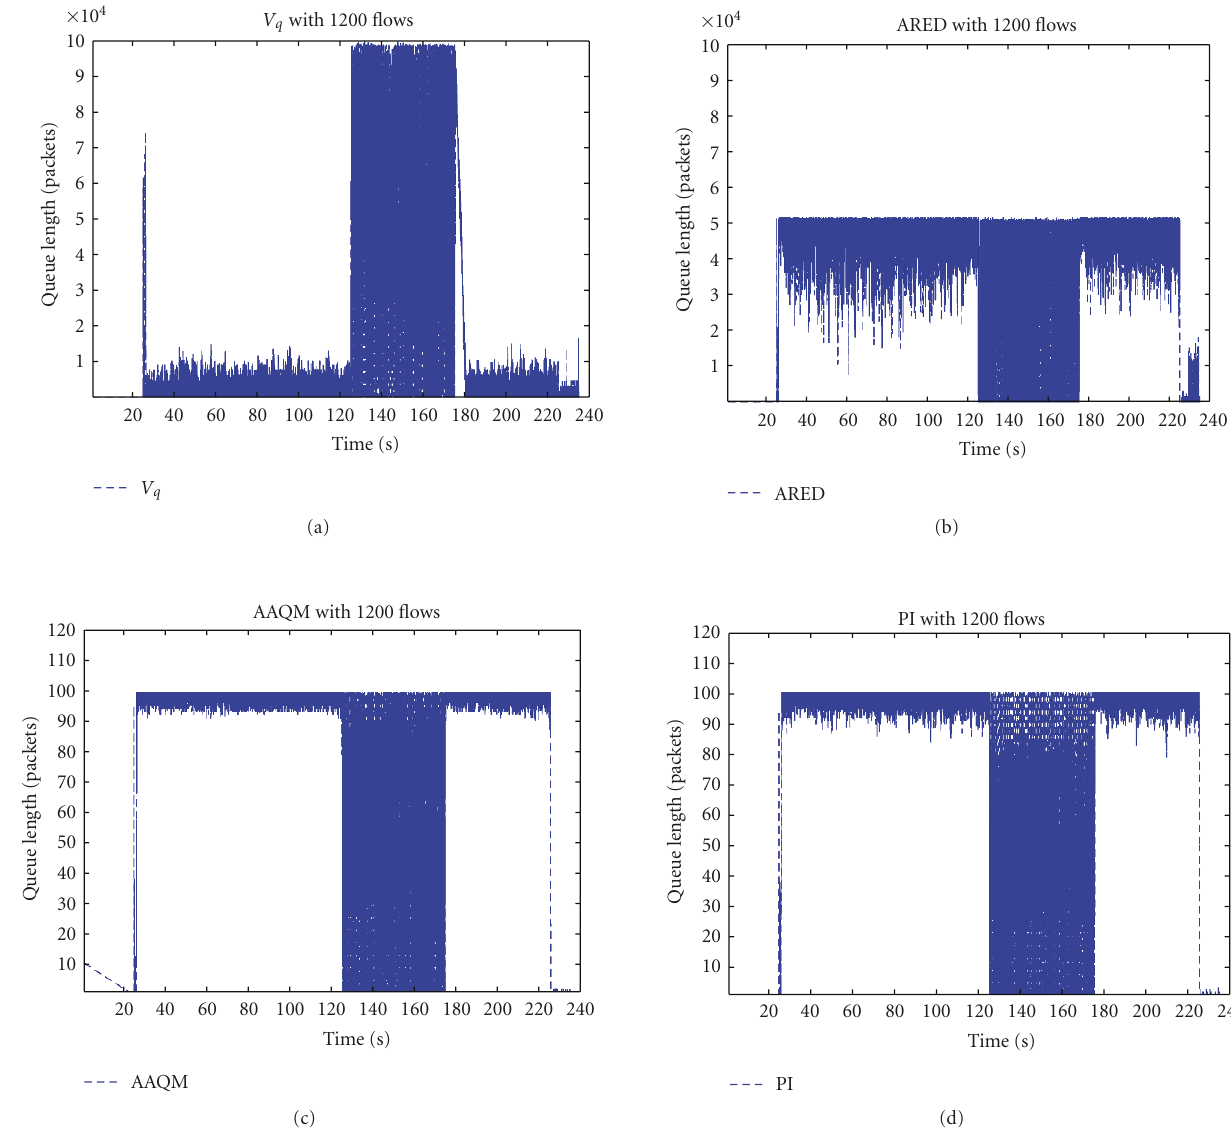
Figure 14: Queue Monitoring with 1200 flows for (a) VQ (b) ARED (c) zooming in AAQM (d) Zooming in PI.